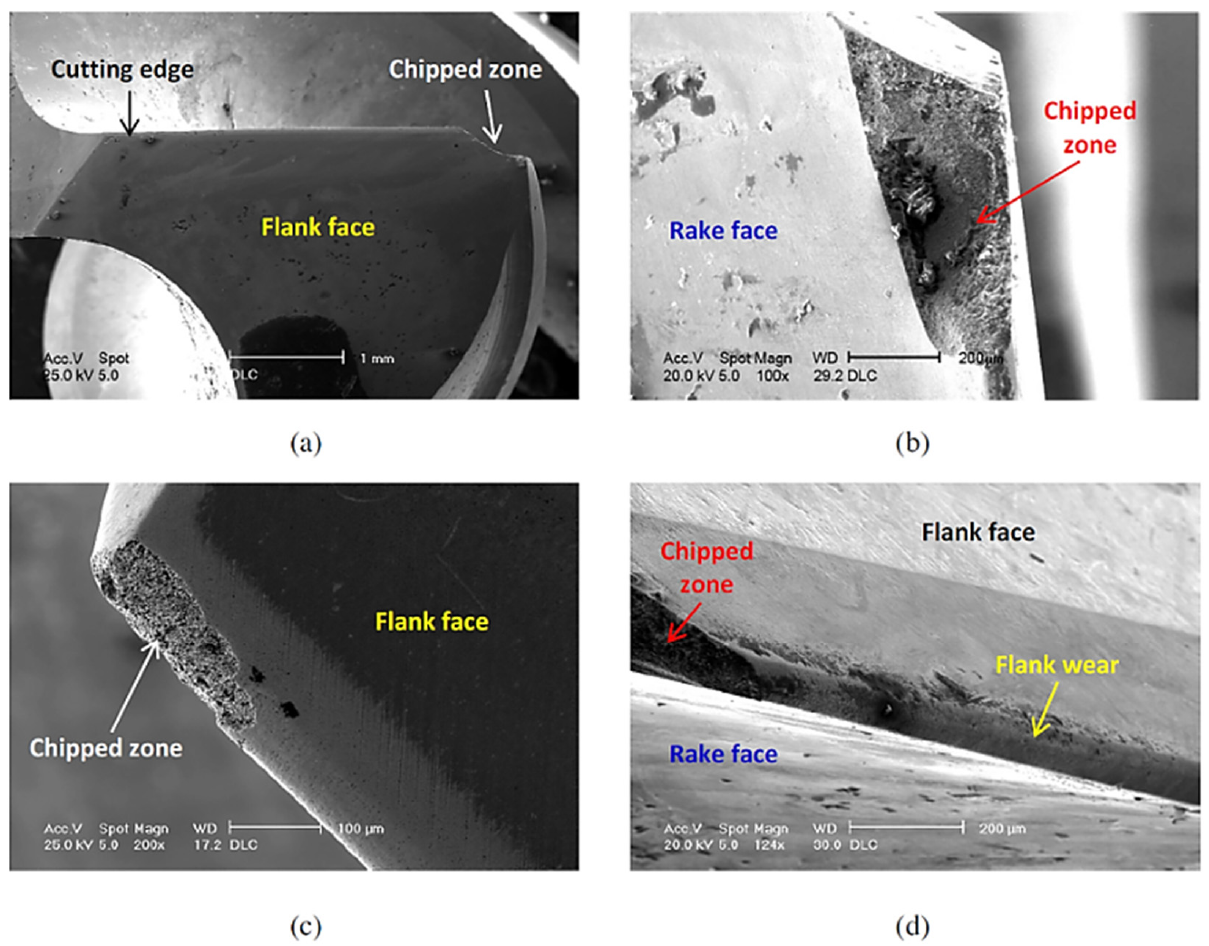
Figure 15. Adhesive wear in a drilling tool: ( a ) edge chipping in the flank face, ( b ) chipped zone in the rake face, ( c ) chipped zone in the flank face and ( d ) flank wear and edge rounding [105] .